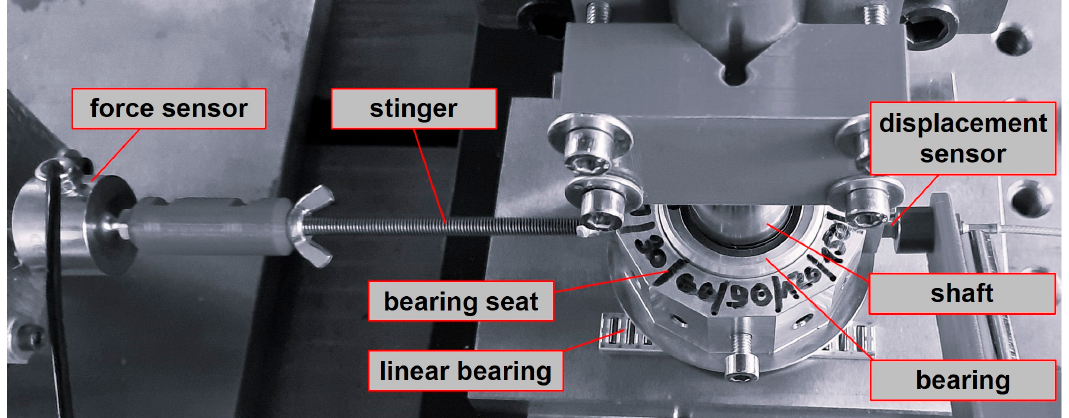
Figure 2. Illustration of the test rig for clearance measurements.